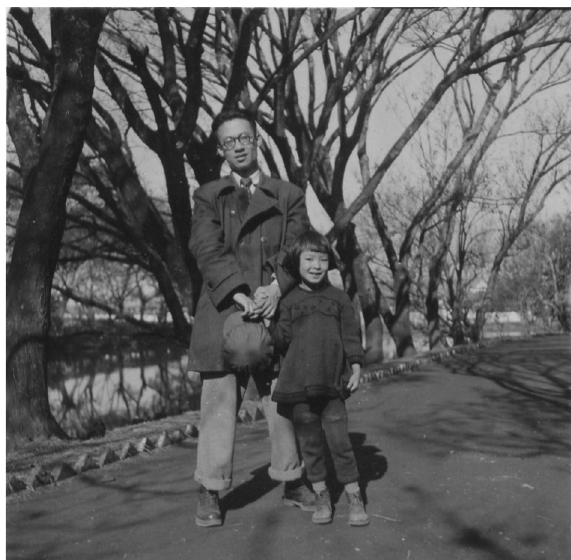
Figure 3. Si-Ho Tchou with his eldest daughter in Yunnan University, circa 1955.